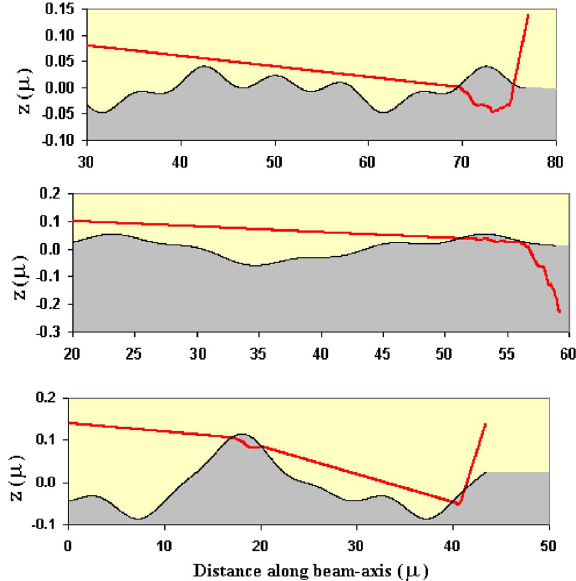
FIG. 3. (Color) Examples of near-grazing trajectories of 182 gold ions generated with the Monte Carlo simulation.